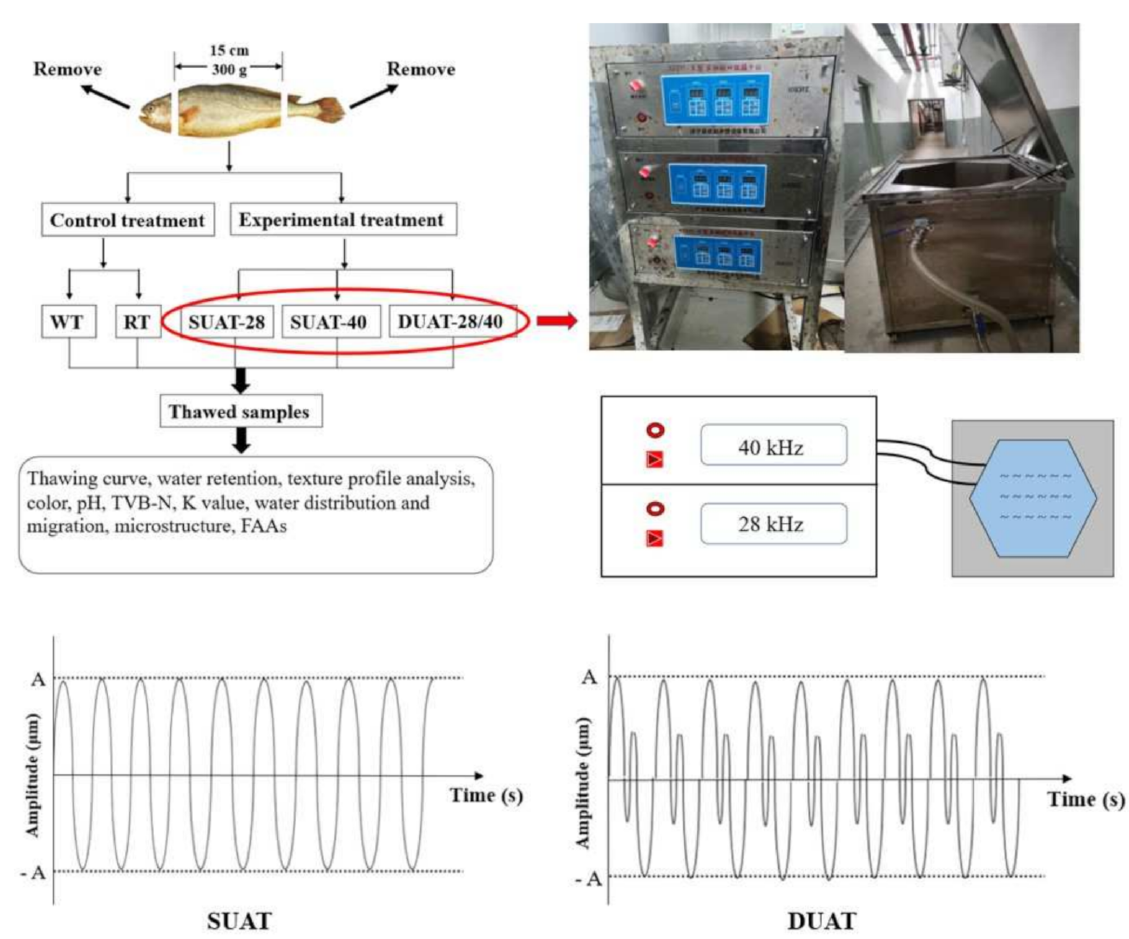
Figure 1. Diagram and possible mechanisms of the ultrasonic thawing